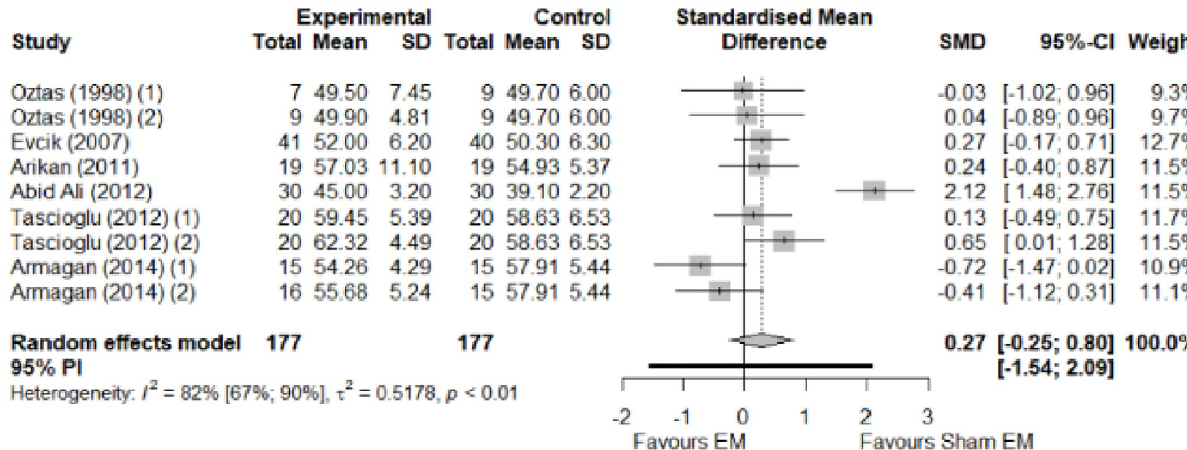
Fig 8. Analysis—Electrophysical modalities versus placebo (motor velocity). Studies with more than two intervention groups (different modalities, treatment doses, or symptom classification) were numbered as (1) and (2).